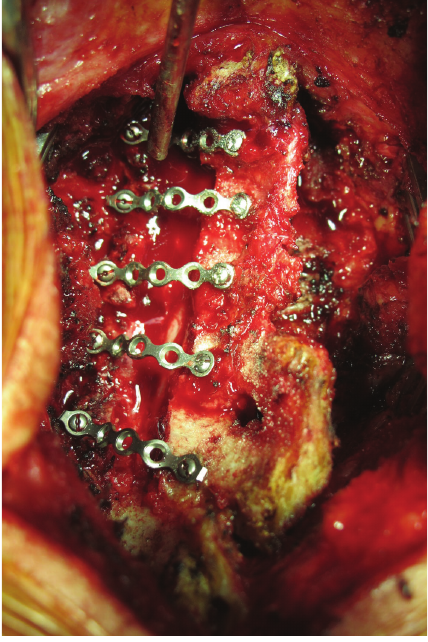
Figure 2: Five maxillofacial titanium miniplates were applied at decompressed